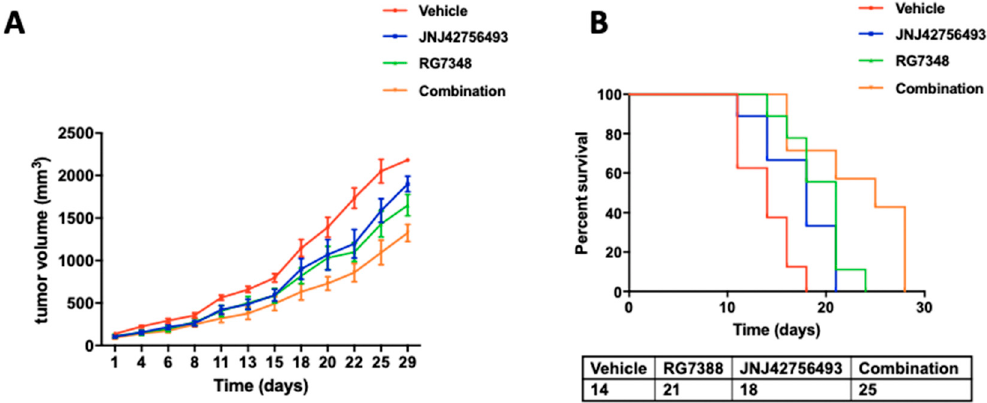
Figure 6. In vivo evaluation of the combination of JNJ42756493 and RG7388. ( A ) Tumor growth in mice injected with DDLPS IB115 cells and treated with either vehicle, RG7388, JNJ42756493, or